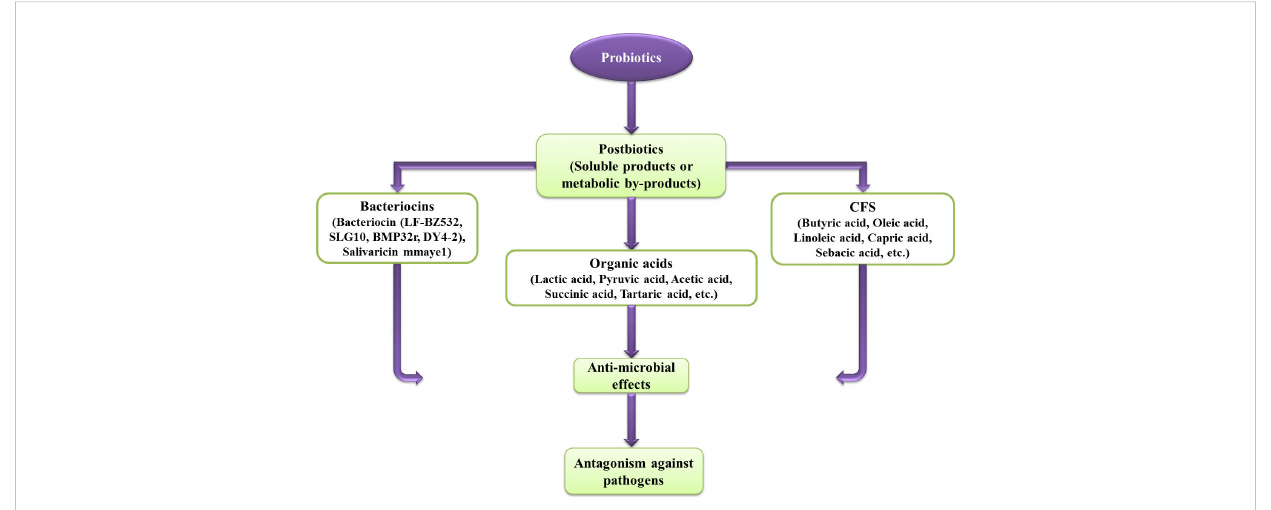
FIGURE 4 The indirect effect of probiotic bacteria through produced